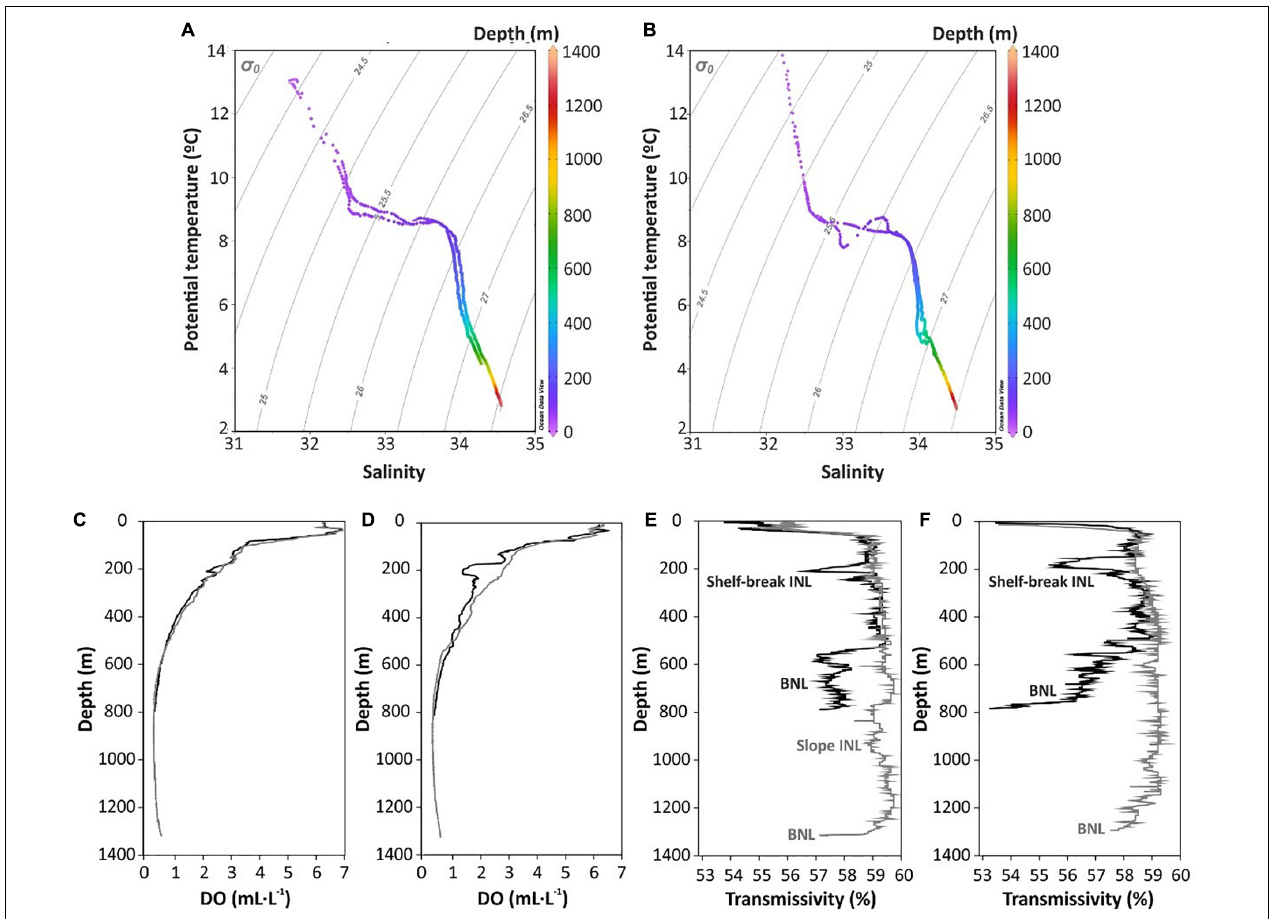
FIGURE 6 | Hydrographic data collected during Line P cruises from year 2018. (A,B) TS diagrams in P03 and P04 stations in summer and fall cruises, respectively. (C,D) Dissolved oxygen (DO, mL · L – 1 ) profiles collected in P03 (black line) and P04 (gray line) stations during summer and fall cruises, respectively. (E,F) Transmissivity (%) profiles collected in P03 (black line) and P04 (gray line) stations during summer and fall cruises, respectively (data plotted using Ocean Data View 4.7.10; http://odv.awi.de; Schlitzer, 2010). For interpretation of the references to color in this figure legend, the reader is referred to the web version of this